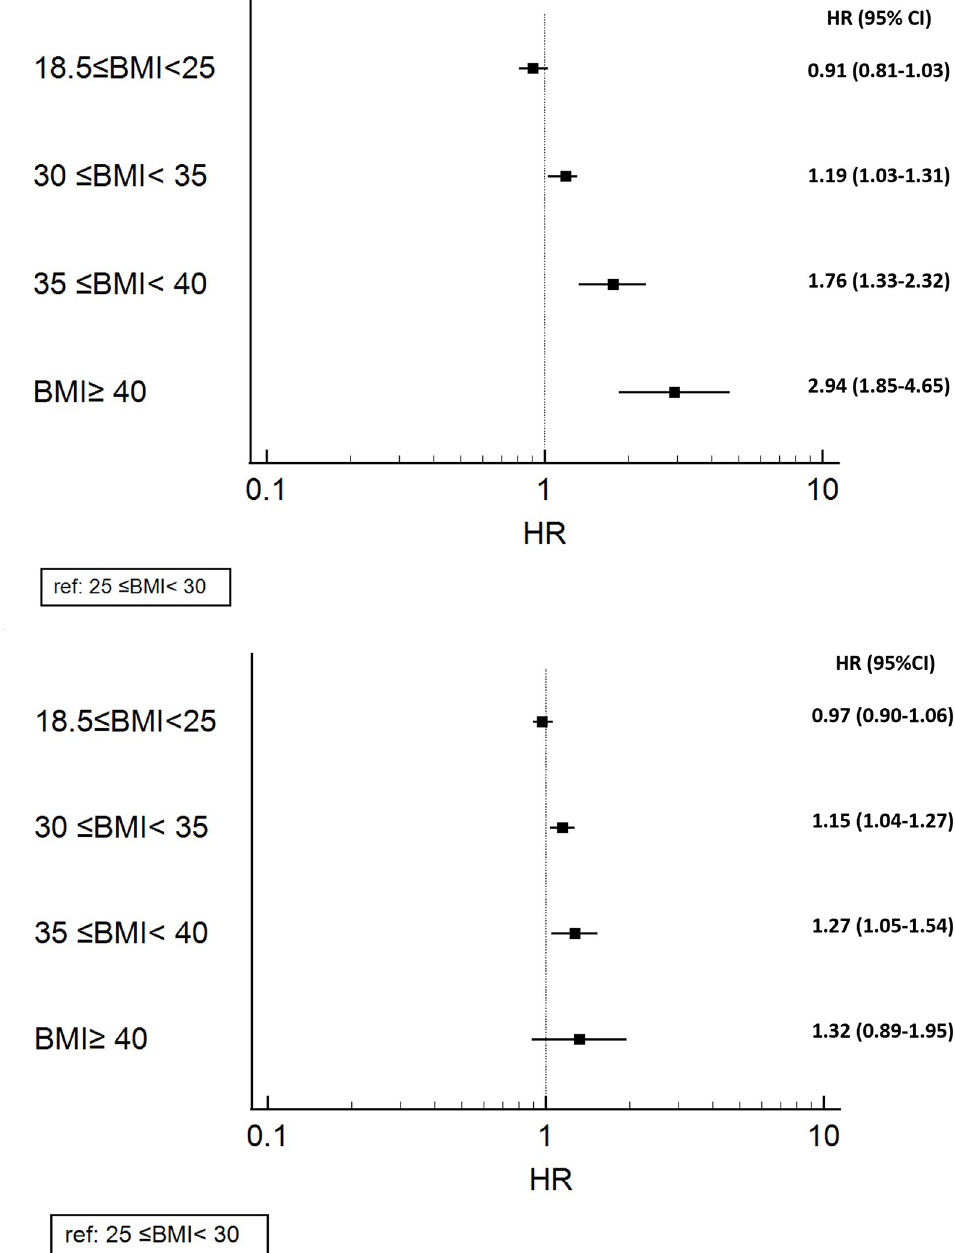
Fig 2. Forest plot of the adjusted effects of different levels of body mass index (BMI) on all-cause mortality and major adverse cardio-cerebrovascular events (MACCEs) after coronary artery bypass graft surgery (CABG).